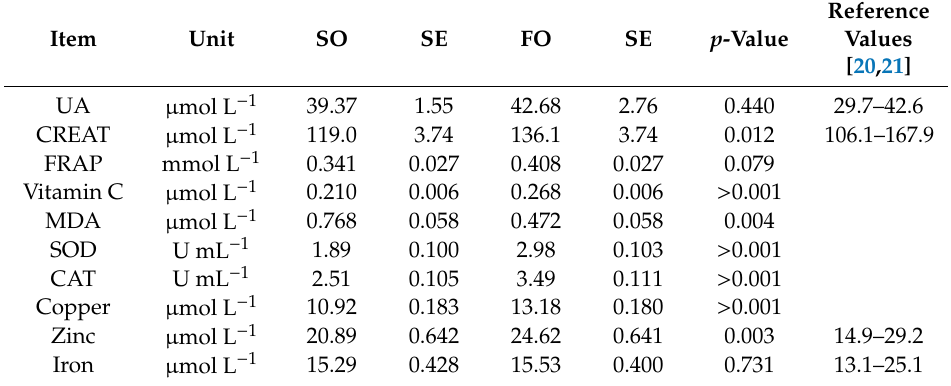
Table 3. E ff ect of dietary oils on redox status parameters (mean ± SE) of the blood plasma of horses.